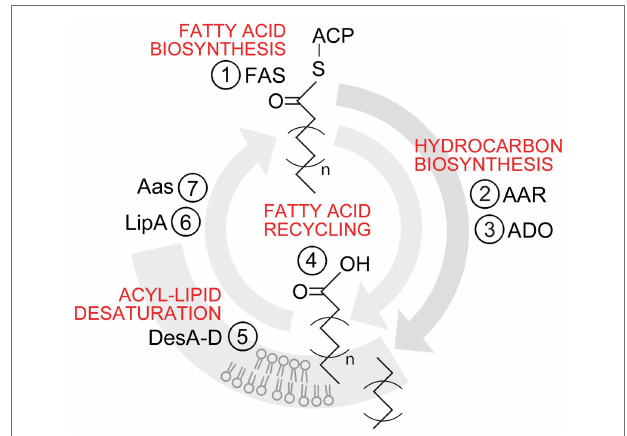
FIGURE 1 | Biosynthesis of saturated and unsaturated aliphatic hydrocarbons via the AAR/ADO pathway in Synechocystis sp. PCC 6803. The (1) fatty acid synthase (FAS) fatty acyl – acyl carrier protein (ACP) serves as the precursor for hydrocarbon biosynthesis. In this process, the fatty acids are first released from ACP and reduced into aldehydes by the (2) fatty acyl- ACP reductase (AAR), followed by the conversion into corresponding C n alkanes or alkenes by the (3) aldehyde deformylating oxygenase (ADO). The product specificity is determined by the length and saturation level of the initial acyl chain, and the hydrocarbons that derive from de novo fatty acid biosynthesis are exclusively linear saturated alkanes. When (4) fatty acids are used as structural components for phospholipid bilayer biosynthesis, the resulting glycerol-linked fatty acyl moieties in the membranes can be unsaturated by (5) the desaturases DesA-D. These products can be released from the membranes by the (6) lipolytic enzyme (LipA), and re- attached to ACP by (7) acyl-ACP synthetase (Aas), which may again serve as precursors for AAR/ADO to produce alkenes. The “n” represents the number of repeating two-carbon units in the carbon chain, and for heptadecane and heptadecene, “ n =